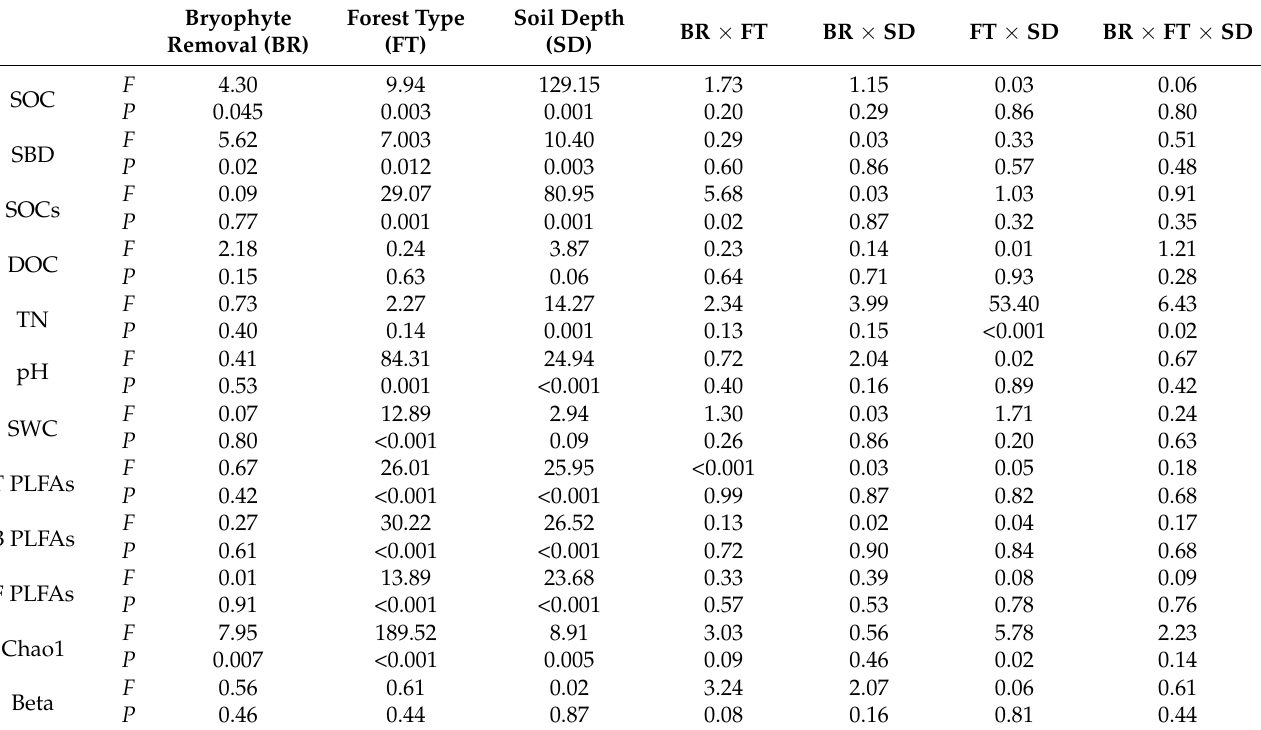
Table A1. Bryophyte removal, soil depth, and forest type were used for three-way